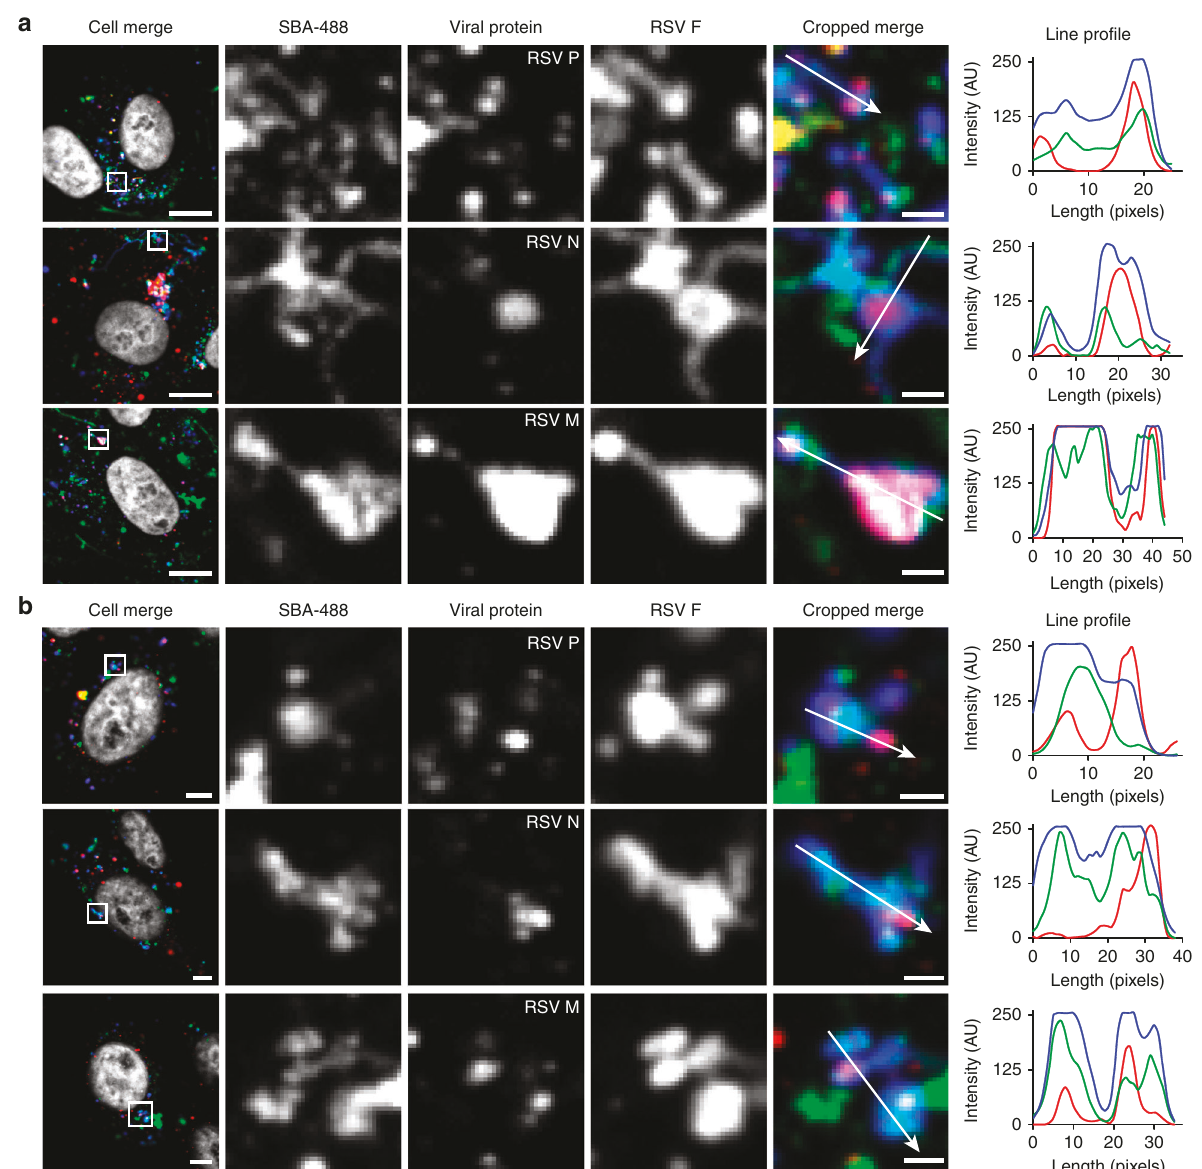
Fig. 8 RNP granules merge with glycoprotein vesicles prior to the plasma membrane. a Vero cells were infected with RSV at an MOI of 1. 12 hpi, SBA-488 ( green ) was delivered and allowed to internalize for 2 h. Cells were then fi xed with 1% PFA, permeabilized with 0.1% saponin, and stained for RSV F ( blue ) and either RSV P, RSV N, or RSV M, as indicated ( red ). Scale bar represents 10 µ m in whole-cell images and 1 µ m in cropped images. Enlargement of cropped image from the white boxed region with an intensity pro fi le showing colocalization along the direction of the white arrow . b The same experiment in a was repeated in SBA-488 ( green ) stained HEp-2 cells. Cells were stained for RSV F ( blue ) and either RSV P, RSV N, or RSV M as indicated ( red ). Scale bar represents 10 µ m in whole-cell images and 1 µ m in cropped images. Enlargement of cropped image from the white boxed region with an intensity pro fi le showing colocalization along the direction of the white